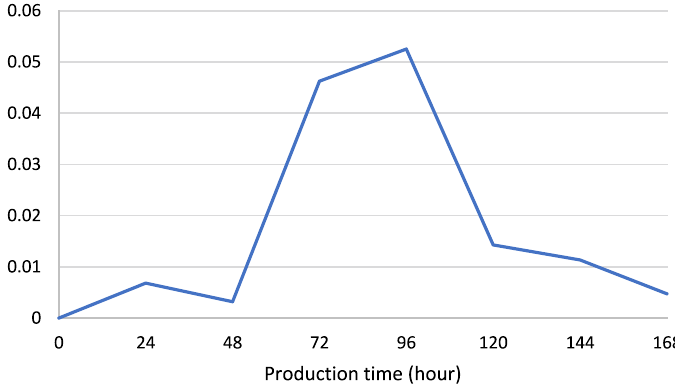
(0.015mM, 0.03mM, 2